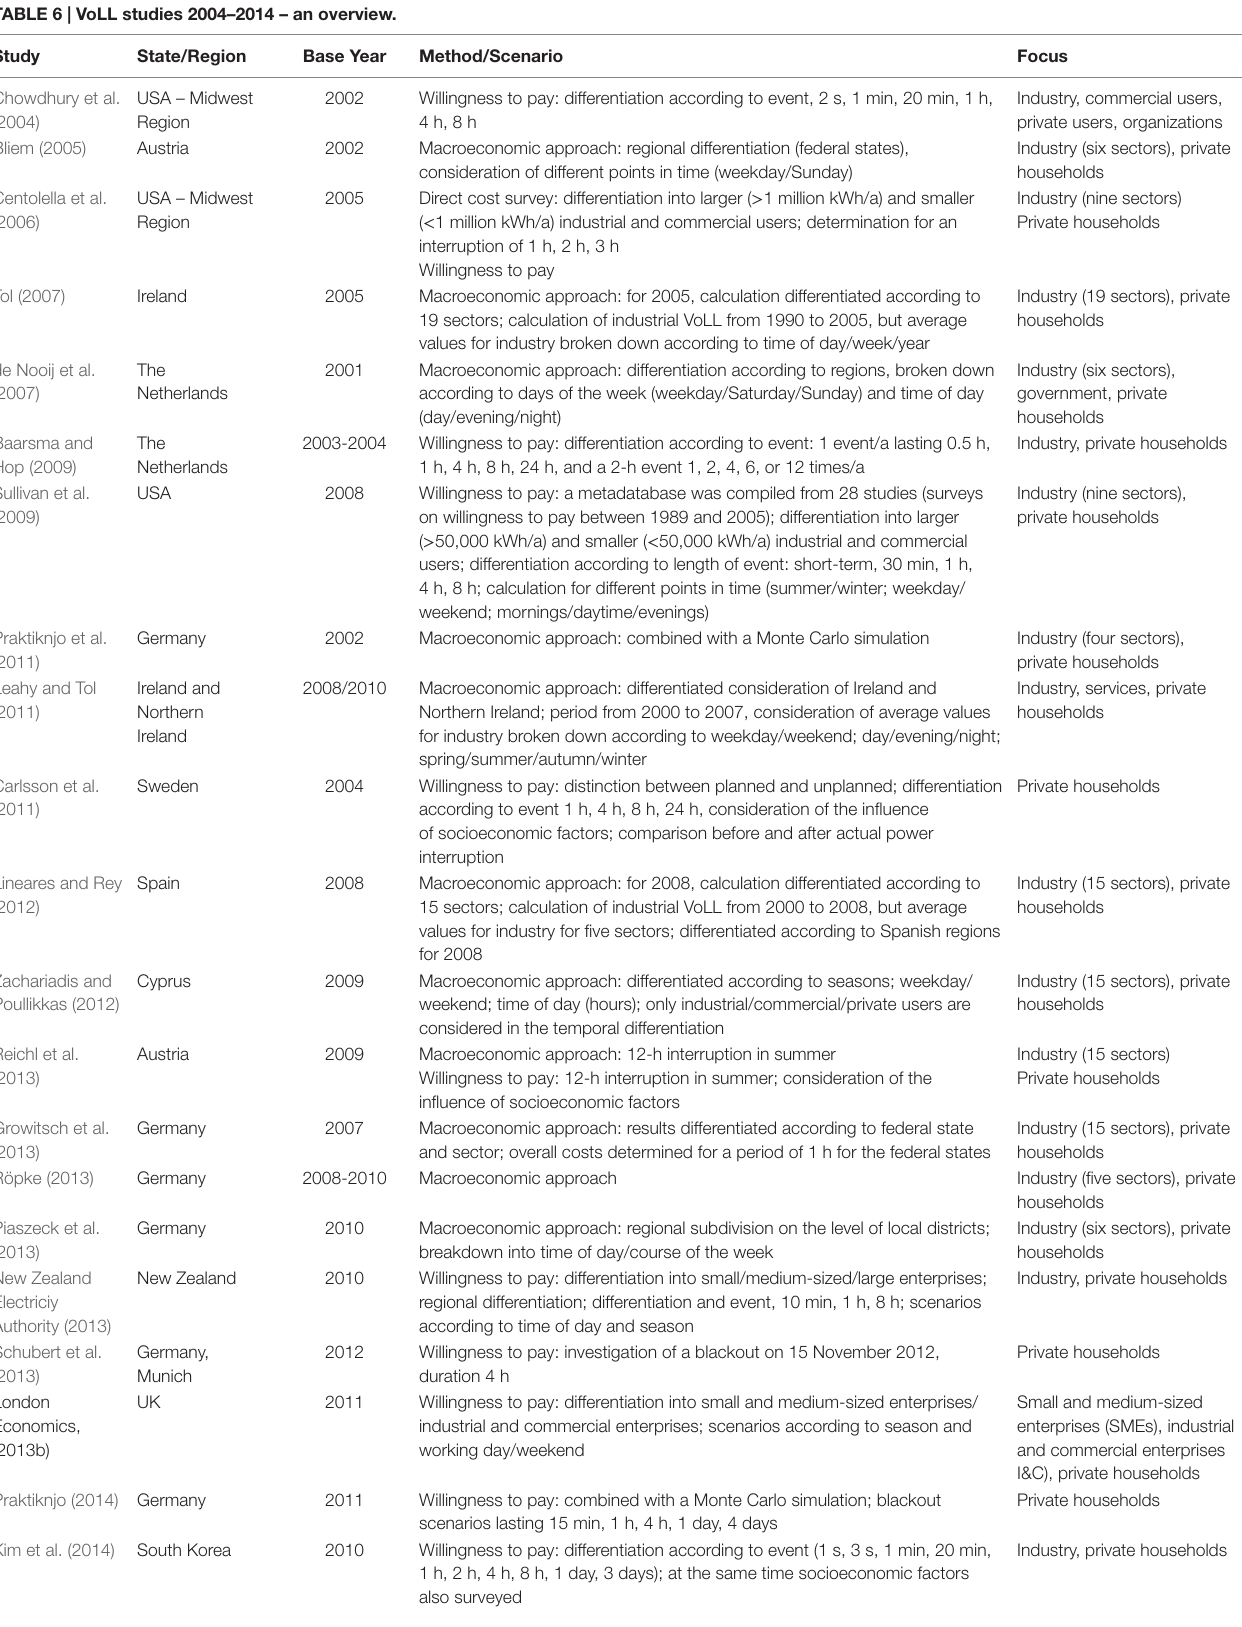
TABLe 6 | voLL studies 2004–2014 – an